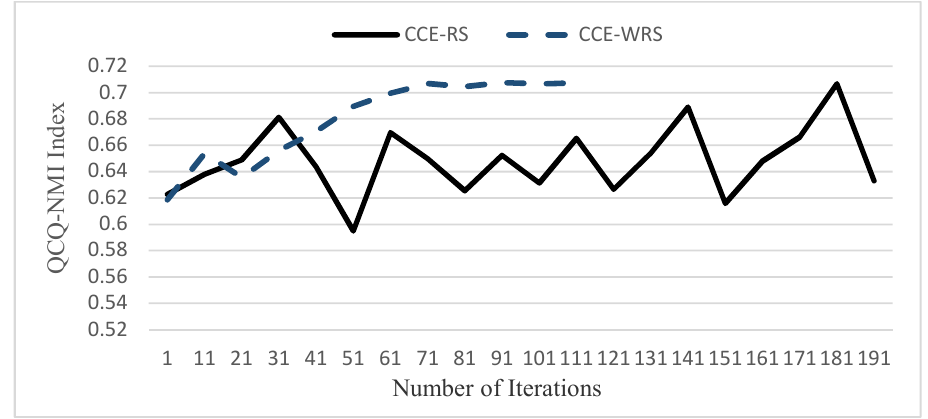
Figure 8. Comparison of clustering efficiency between RS-CCE and WRS-CCE algorithms.